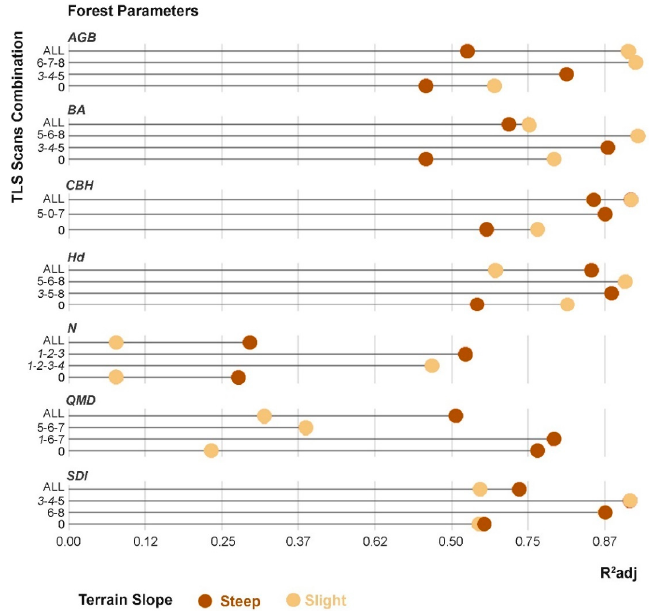
Figure 7. Summary of R 2 adj values for the estimated forest parameters as a function of terrain slope (slight slope in light brown color and steep slope in dark brown color), and scan combinations using all the combinations (31), a specific scan combination (in italics the positions located at 15 m), and the central one as a single scan (0). Focusing on the use of the selected multiple linear regression models having the highest R 2adj values, Figure 8 shows the scatterplot of predicted and observed values of the seven forest parameters ( AGB , BA , CBH , Hd , N , QMD, and SDI ). The most accurate esti- mations, with an R 2adj close to 0.9, were obtained for AGB , BA , CBH , Hd , and SDI forest parameters, also reaching a low RMSE (e.g., 0.8 m for Hd , 0.7 m for CBH ). On the contrary, the least accurate estimations were obtained for N and QMD , where the R 2adj values were below 0.75, and the RMSE were equal to 7.31 trees·plot − 1 and 2.11 cm for N and QMD , respectively. In addition, the results of the equivalence test for these forest parameters show that they are statistically equivalent in terms of bias.